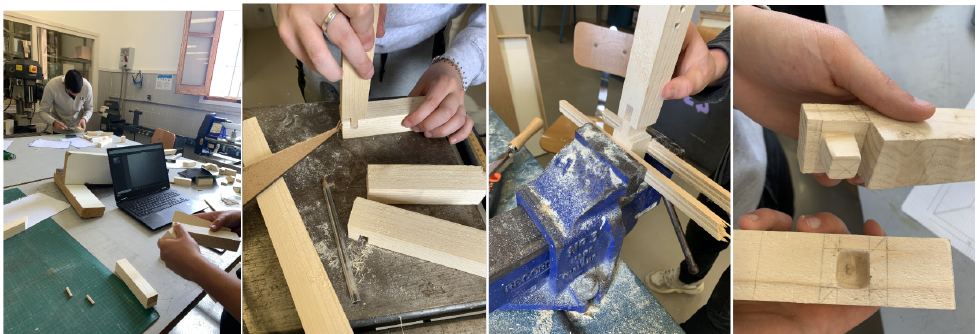
Figure 4. The letters challenge. Pictures of the building